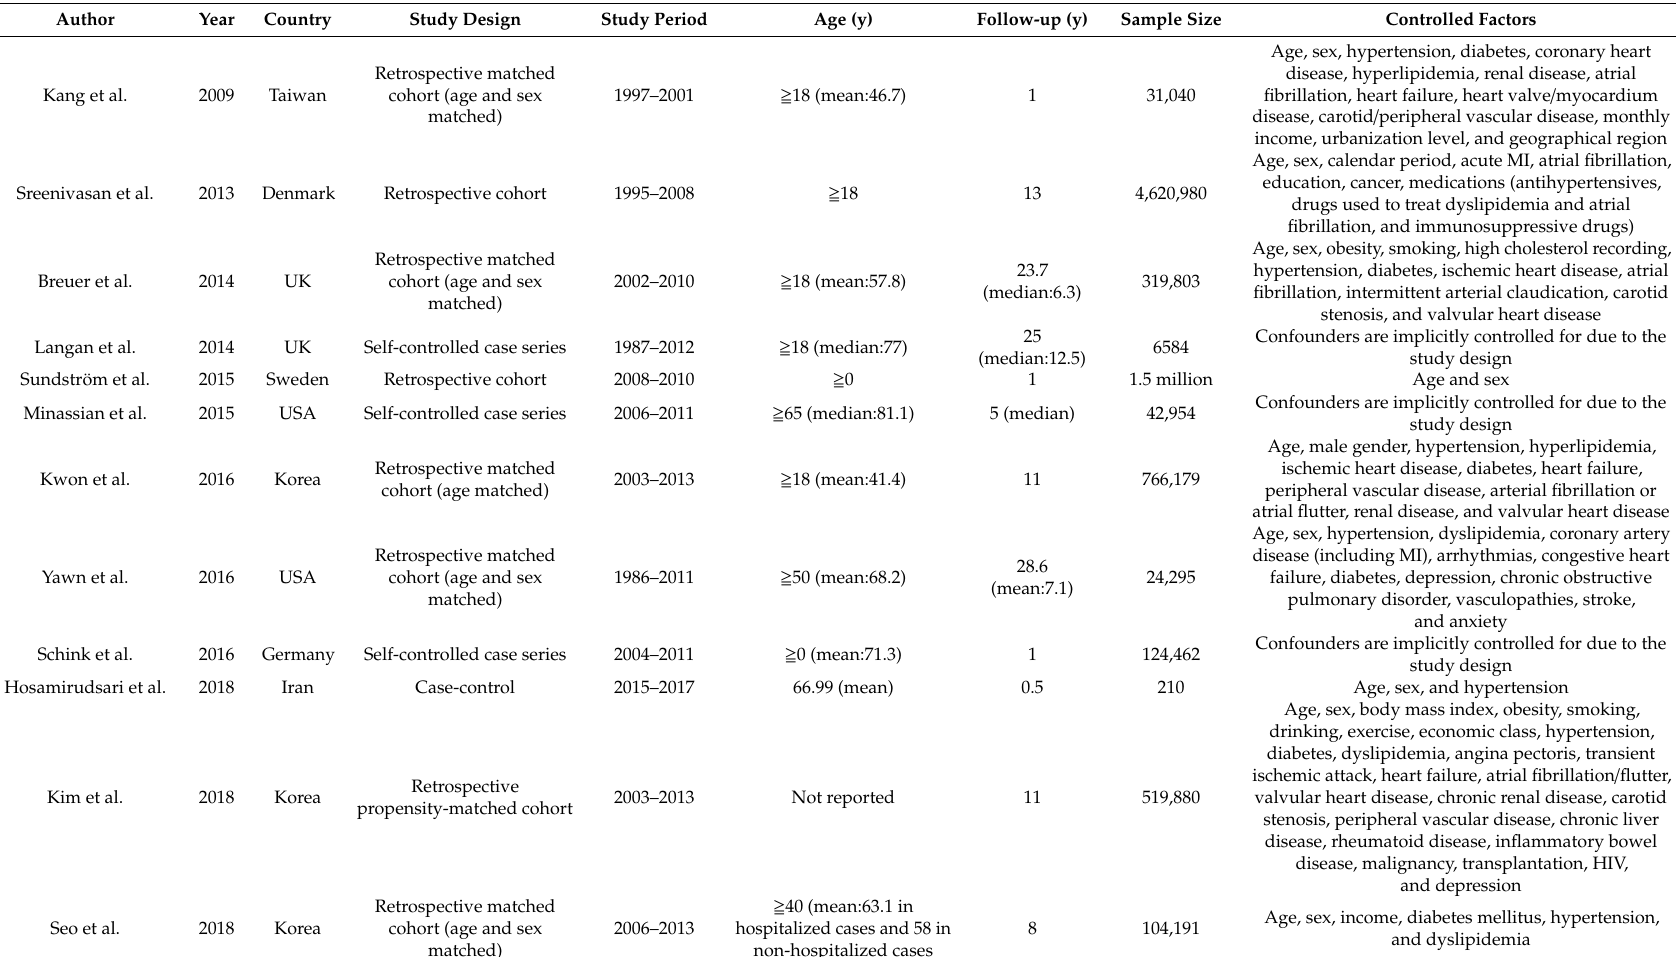
Table 1. Studies that investigated herpes zoster and the risk of stroke or transient ischemic